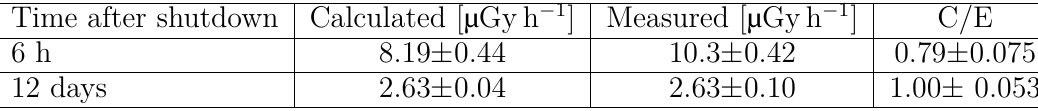
Table 1: Comparison of measured and calculated dose rates µ Gy h − 1 in the Ionization chamber of JET octant 1. Dose rates calculated by other code packages and measured dose rates obtained from [10]. 1 σ uncertainties are